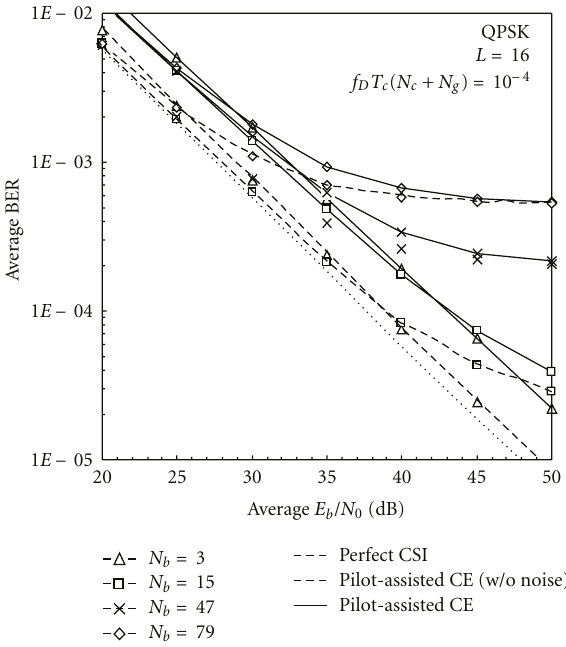
Figure 8: BER performance.